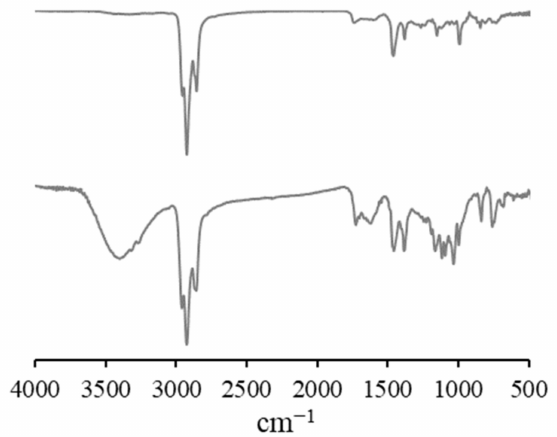
Figure 2. FT-IR spectra of the initial petroleum vanadyl porphyrins ( top ) and of their free porphyrin bases ( bottom ).